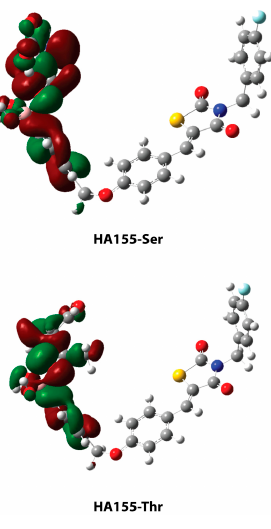
Figure 6. Highest occupied molecular orbitals (HOMOs) of the HA155- Ser ( top ) and HA155- Thr ( bottom ) at the B3LYP/6-31+G(d,p) level of theory.